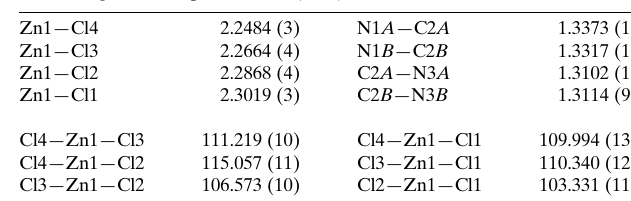
Table 1 Selected geometric parameters (A˚ , (cid:5) ).